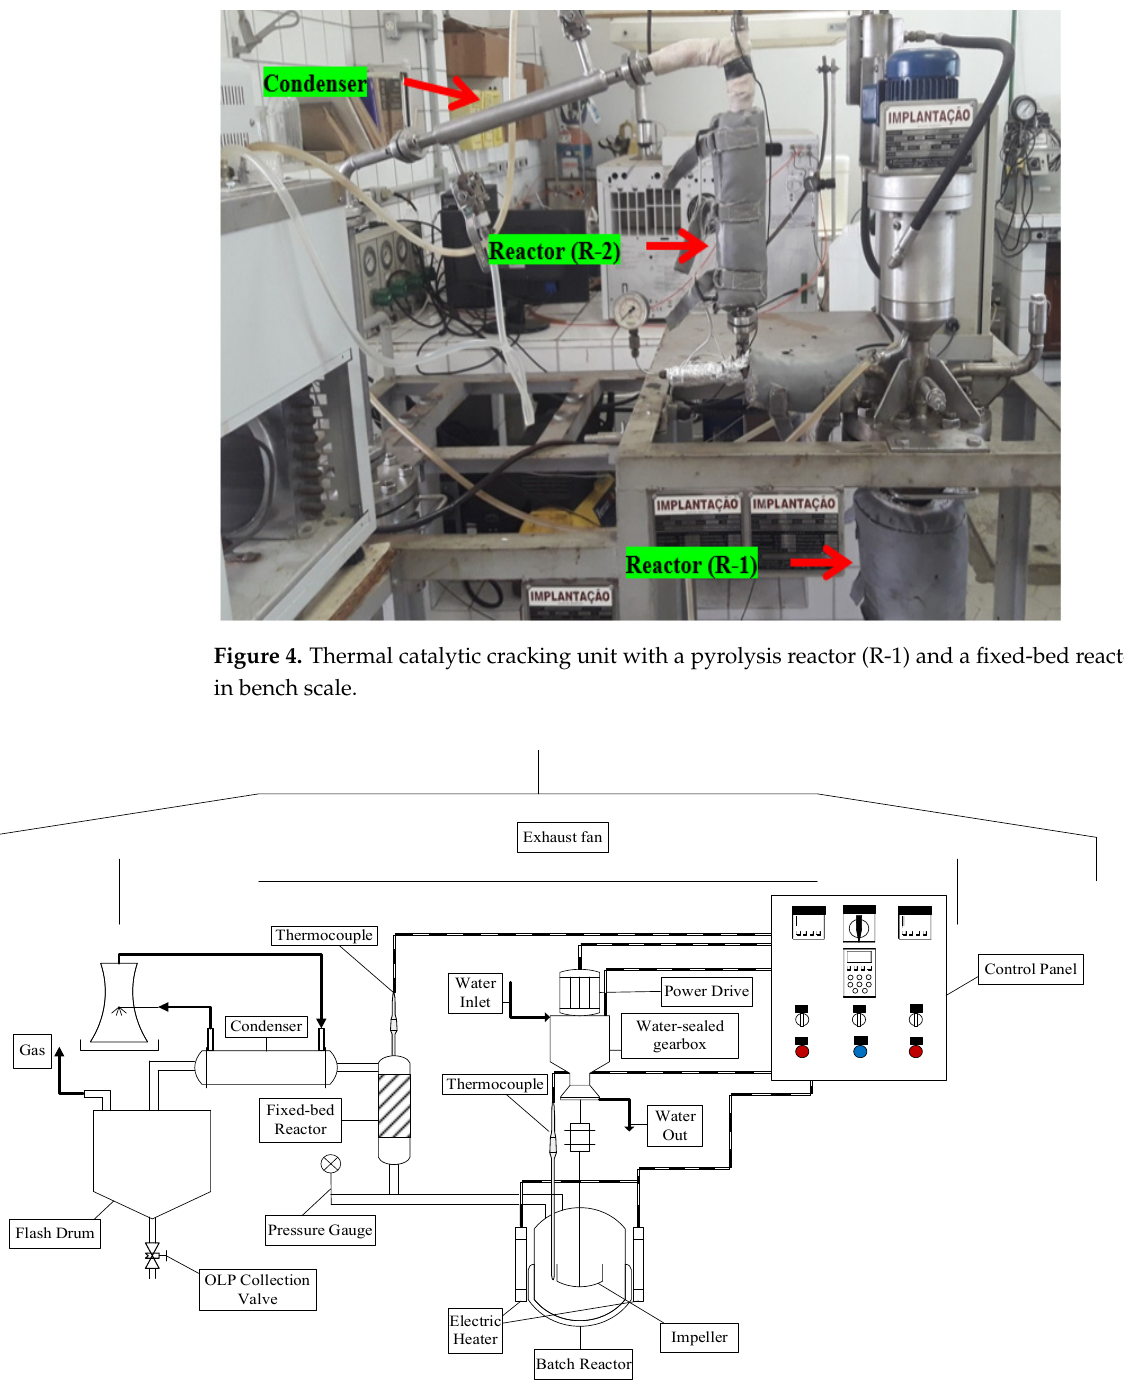
Figure 5. Schematic diagram of bench scale stainless steel catalytic cracking reactor with a pyroly- sis/batch reactor and a fixed-bed reactor.